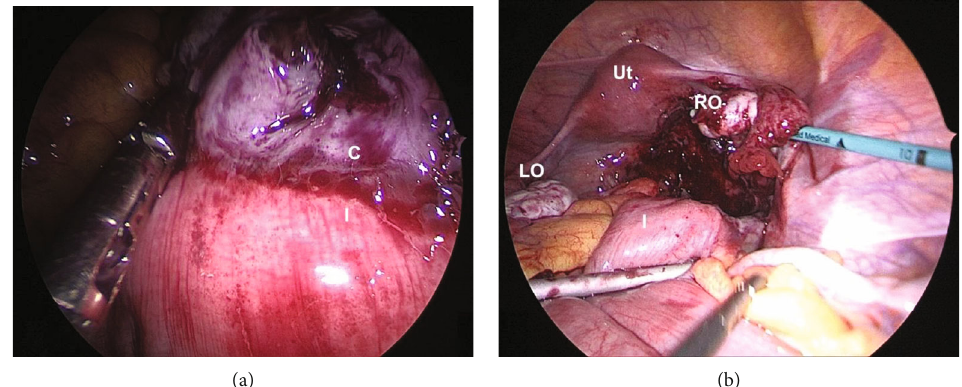
Figure 2: Intraoperative images obtained during laparoscopic cystectomy. (a) Cyst wall (C) fi rmly adherent to terminal ileum (I). (b) Normal uterus (Ut) and left and right ovaries (LO, RO) demonstrated postcystectomy.